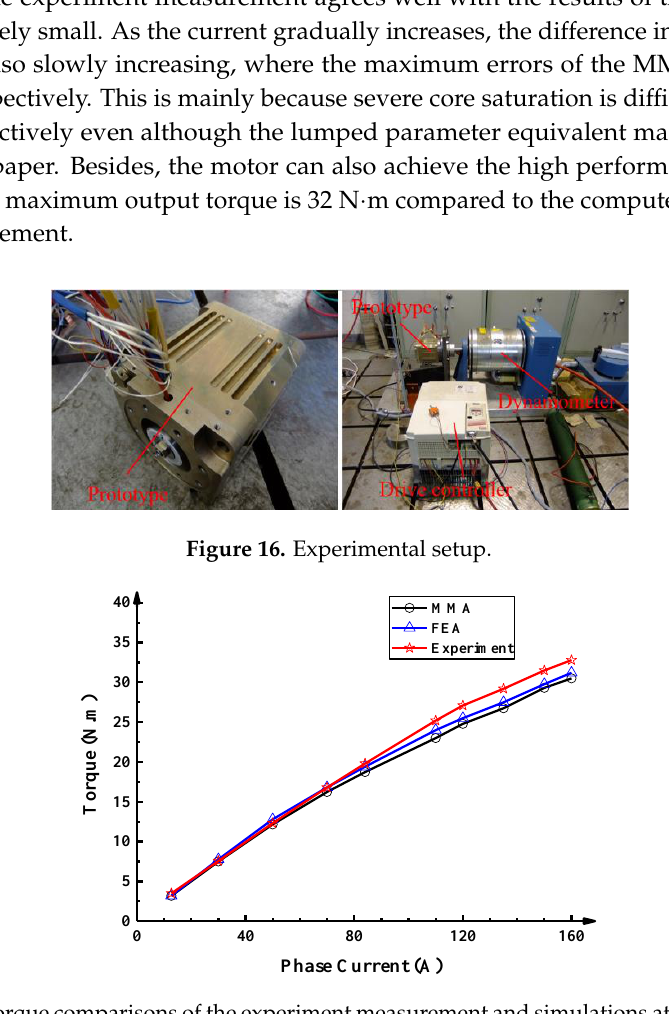
Table 3. Working time under different current density condition.